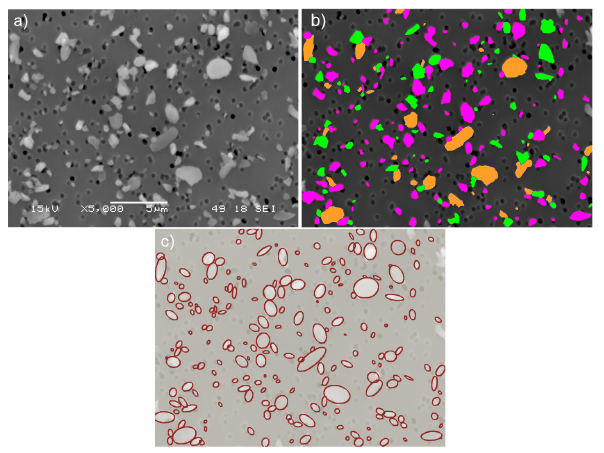
Figure 4. Particle’s number, surface area, and volume distribution vs. particle diameter (per cm 2 of filters) obtained by analysis of SEM images for a fine and a coarse filter of the Eyjafjallajökull vol- canic ash. Distributions are normalized by the width of the bins to show the area below the curve proportional to the number concen- tration, following the form discussed in Seinfeld and Pandis